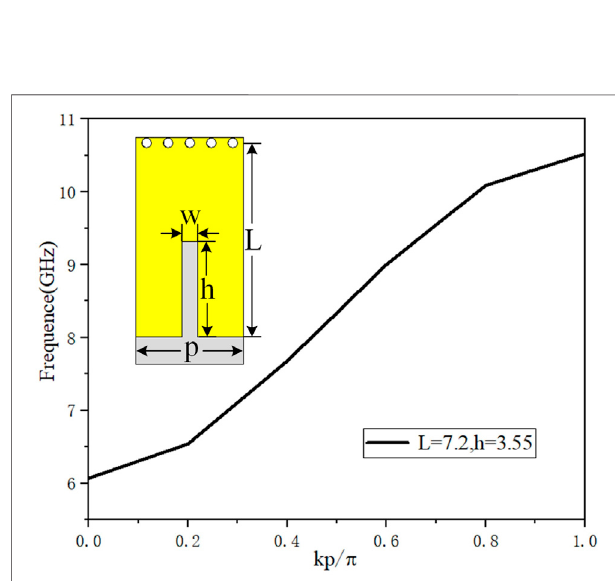
FIGURE 2 | The dispersion curves of the hybrid HMSIW-SSPP unit. Inset: the structure of the hybrid HMSIW-SSPP unit.